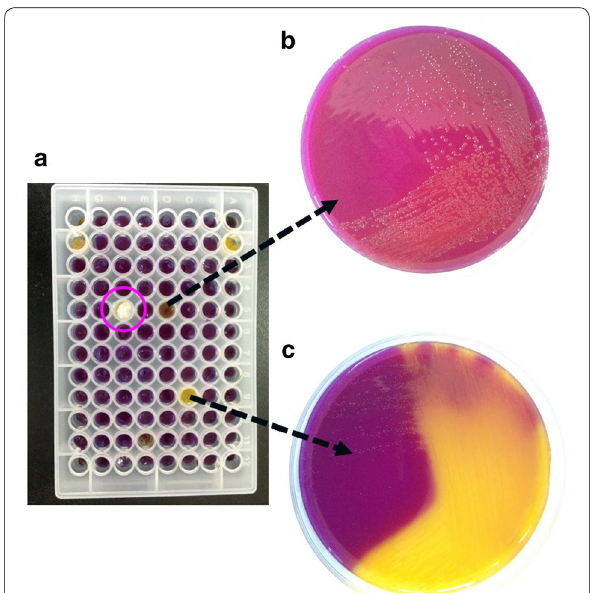
Fig. 2 Photographs of a a 96‑well iPSB screening microplate contain‑ ing PVK media, b an uncertain strain and c an iPSB strain cultivated on a PVK medium plate with color change. The purple circle indicates that fungal growth was confined to a single